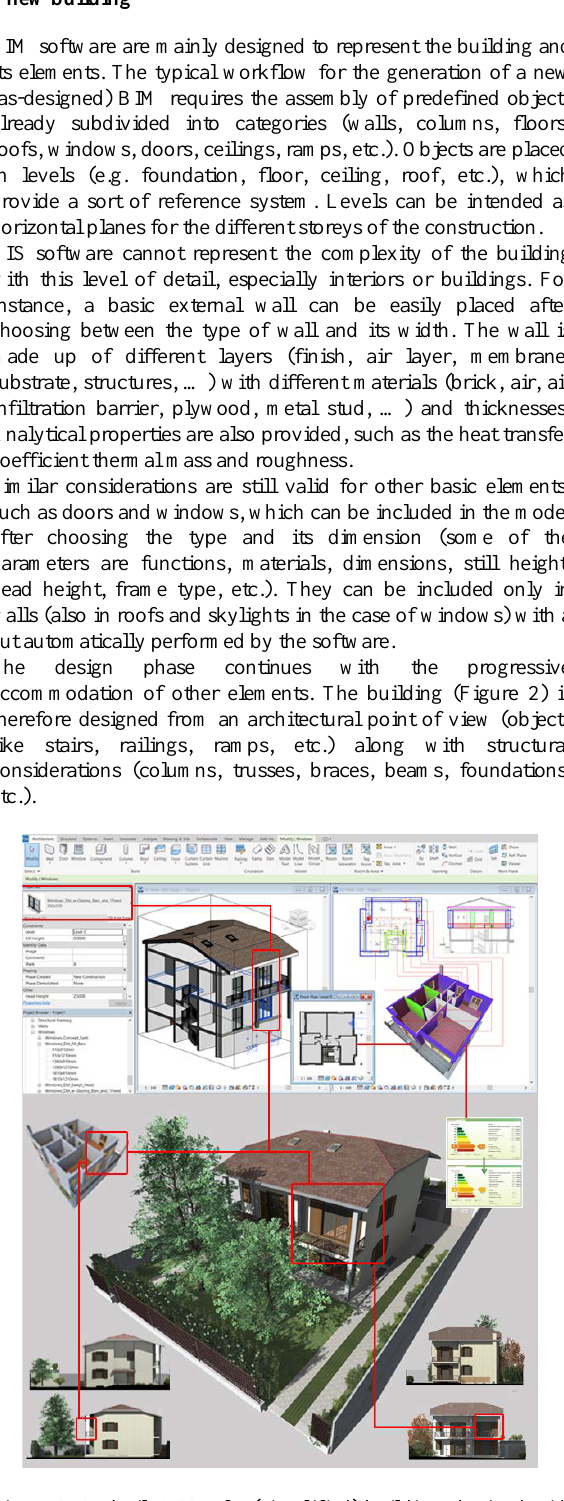
the software (Fig. 2,